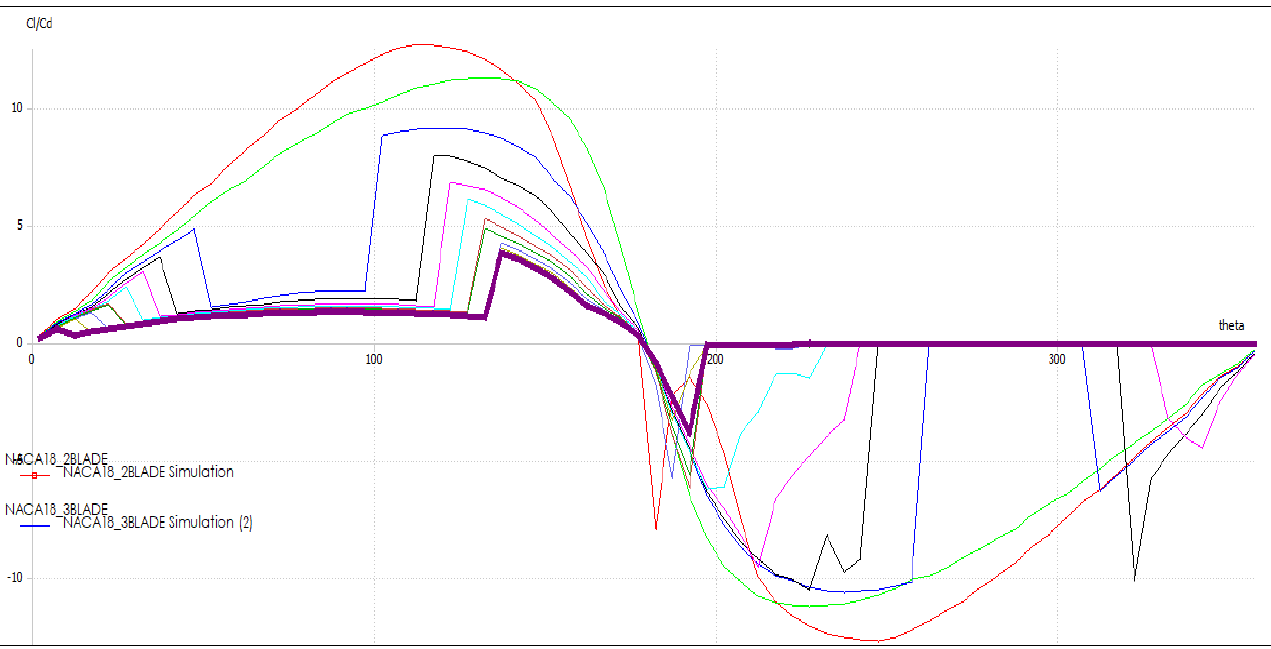
Fi gure 38. Cl/Cd vs theta plot of top-section for TSR